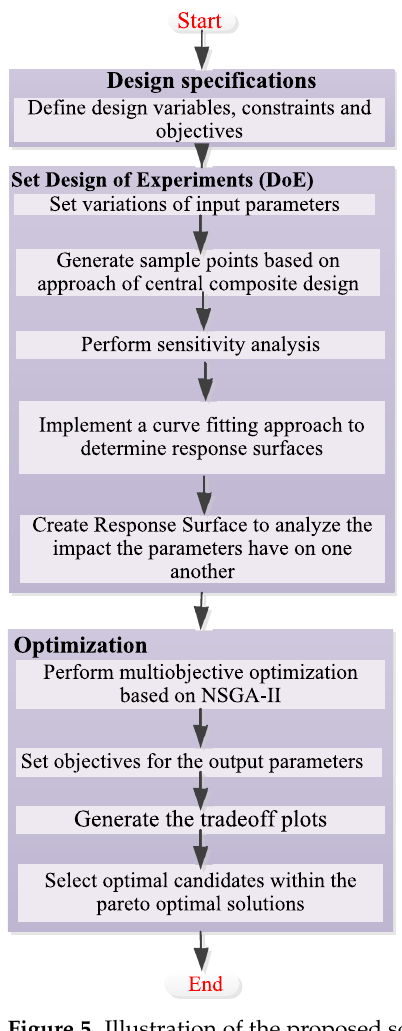
Figure 5. Illustration of the proposed scheme implemented in ANSYS workbench. As shown, the process can be broadly split into three sub-process viz: design specifications, DoE and optimization.